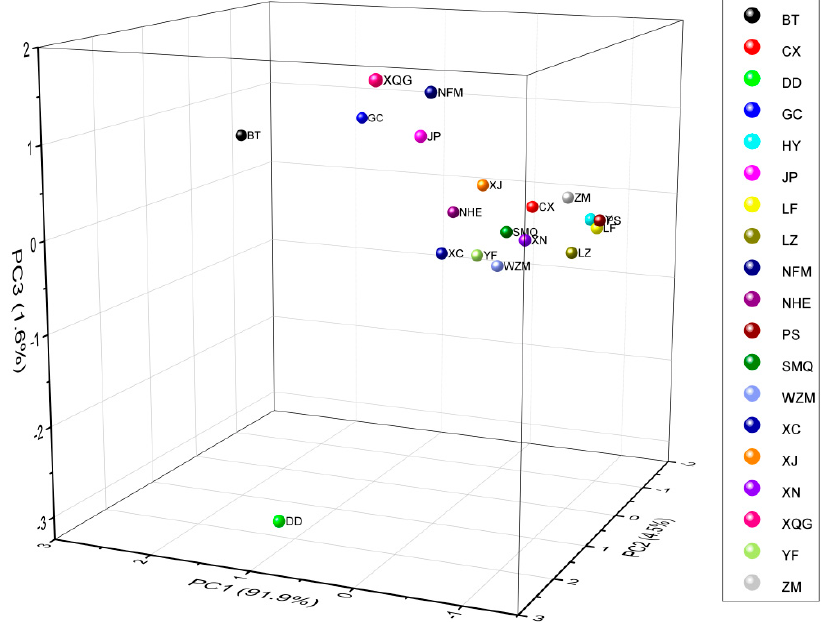
Figure 6. Score plot of the first three principal components of key aroma compounds (OAV > 1) based on HS-SPME-GC-MS data.